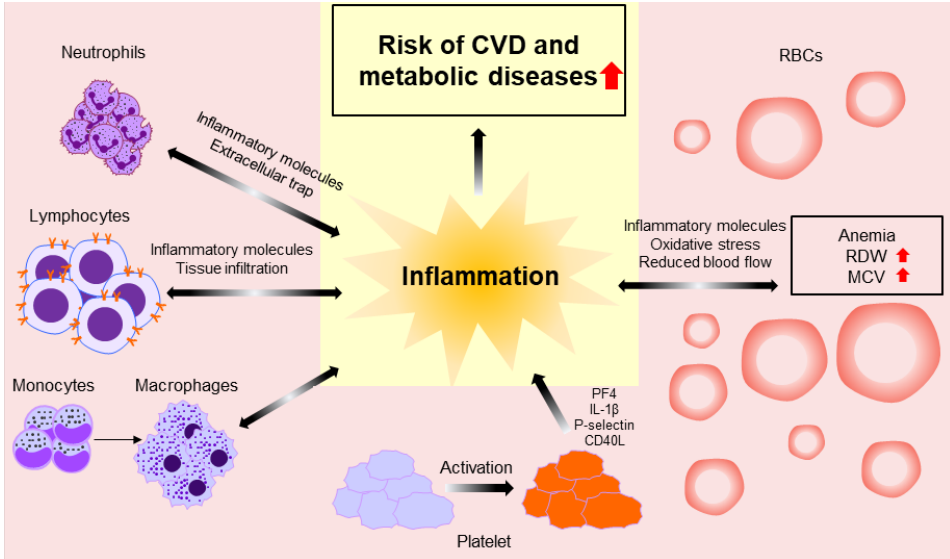
Figure 1. Schematic diagram showing the pathophysiology between CBC components and diseases.